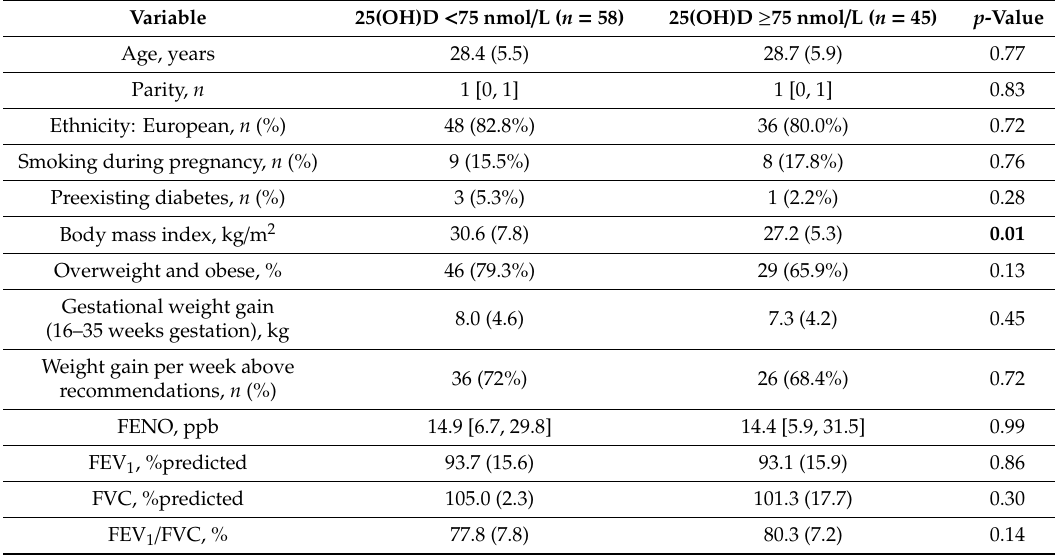
Table 1. Demographics by maternal vitamin D status during pregnancy for women with asthma.